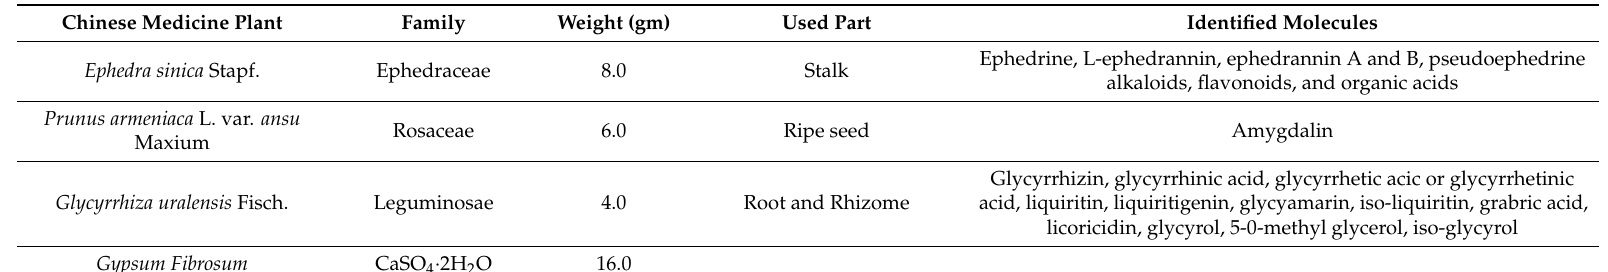
Table 3. Composition Ma-Xing-Gan-Shi-Tang (MXGST)